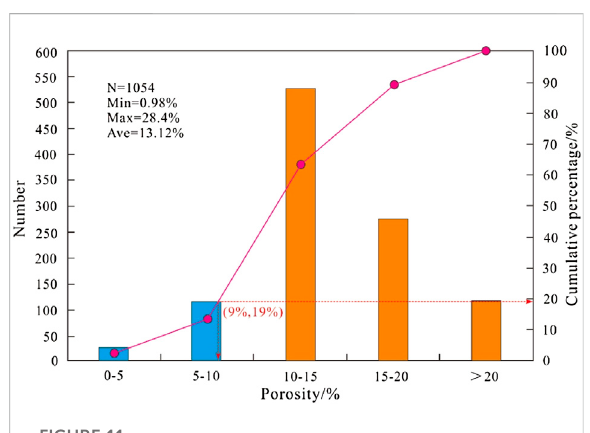
FIGURE 11 The lower limit of porosity of the Carboniferous volcanic in the Shixi Oil fi